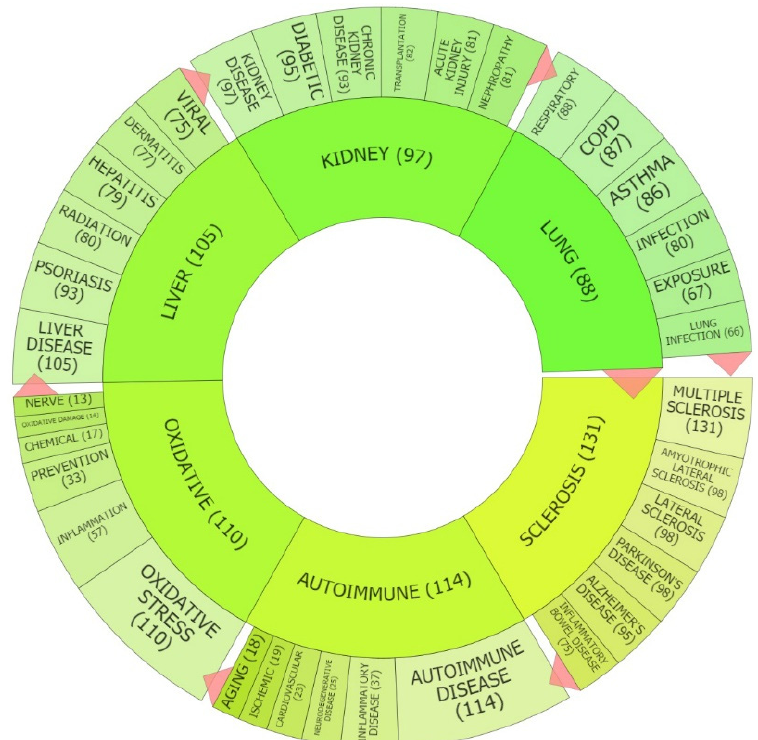
Figure 3. Clustering of the most enriched topics extracted from Kelch-like ECH-associated protein 1 (Keap1)/Nrf2 patents published from January 2017 to May 2020 using the PatSeer Pro platform. The number next to each topic indicates the number of patents discussing this topic. The major topics are depicted closer to the center of the circle and their relevant subtopics on the outer periphery of the circle.